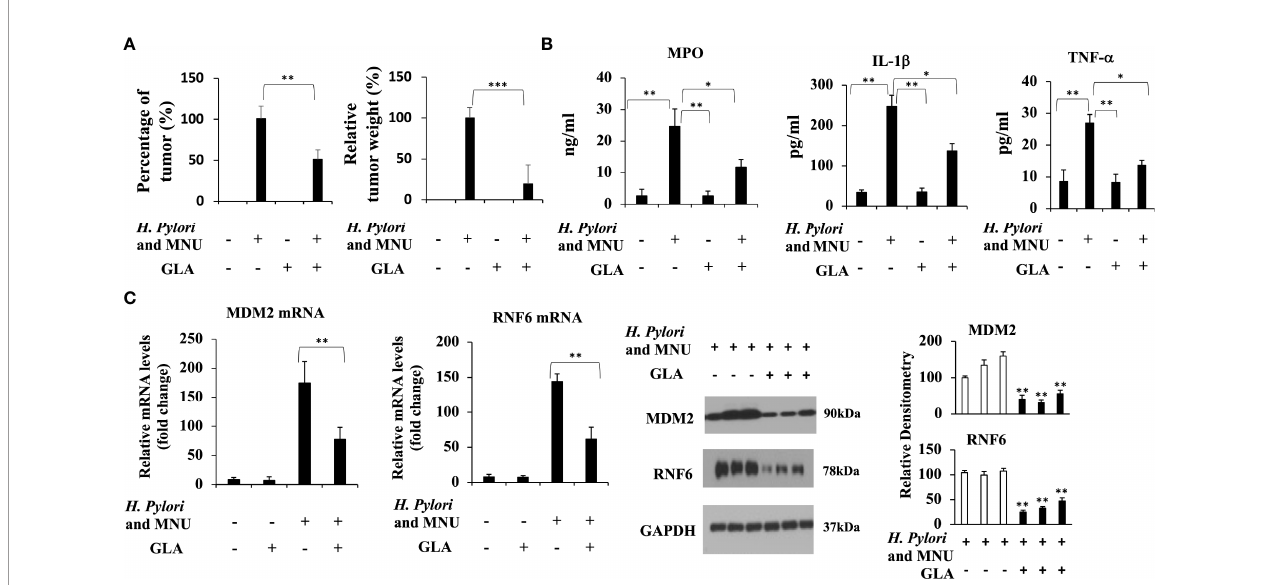
FIGURE 6 | The inhibitory effect of GLA in the in vivo gastric cancer mouse model. (A) The incidence and relative tumor weight of gastric tumors at 18 weeks after MNU induction. The incidence was calculated as the percentage of tumor-bearing mice/total mice in each group. (B) The mucosal levels of MPO and pro-in fl ammatory cytokines, IL-1 b and TNF- a in group, were examined at 18 weeks after MNU induction. (C) The expression of MDM2 and RNF6 at mRNA and protein levels in stomach tissues in each group. The Western blot analysis was repeated three times. The data represented the mean ± SD (n=3). * p < 0.05, ** p < 0.01, *** p <